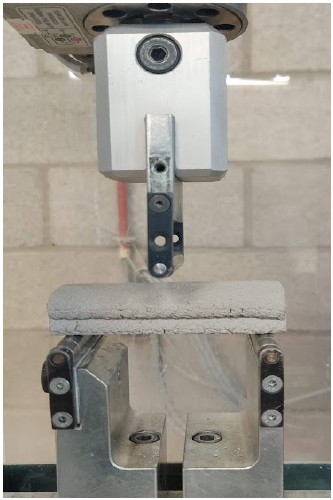
Figure 3. Three-point bending test set-up. 2.6. Pore Structure Assessment by Mercury Intrusion Porosimetry